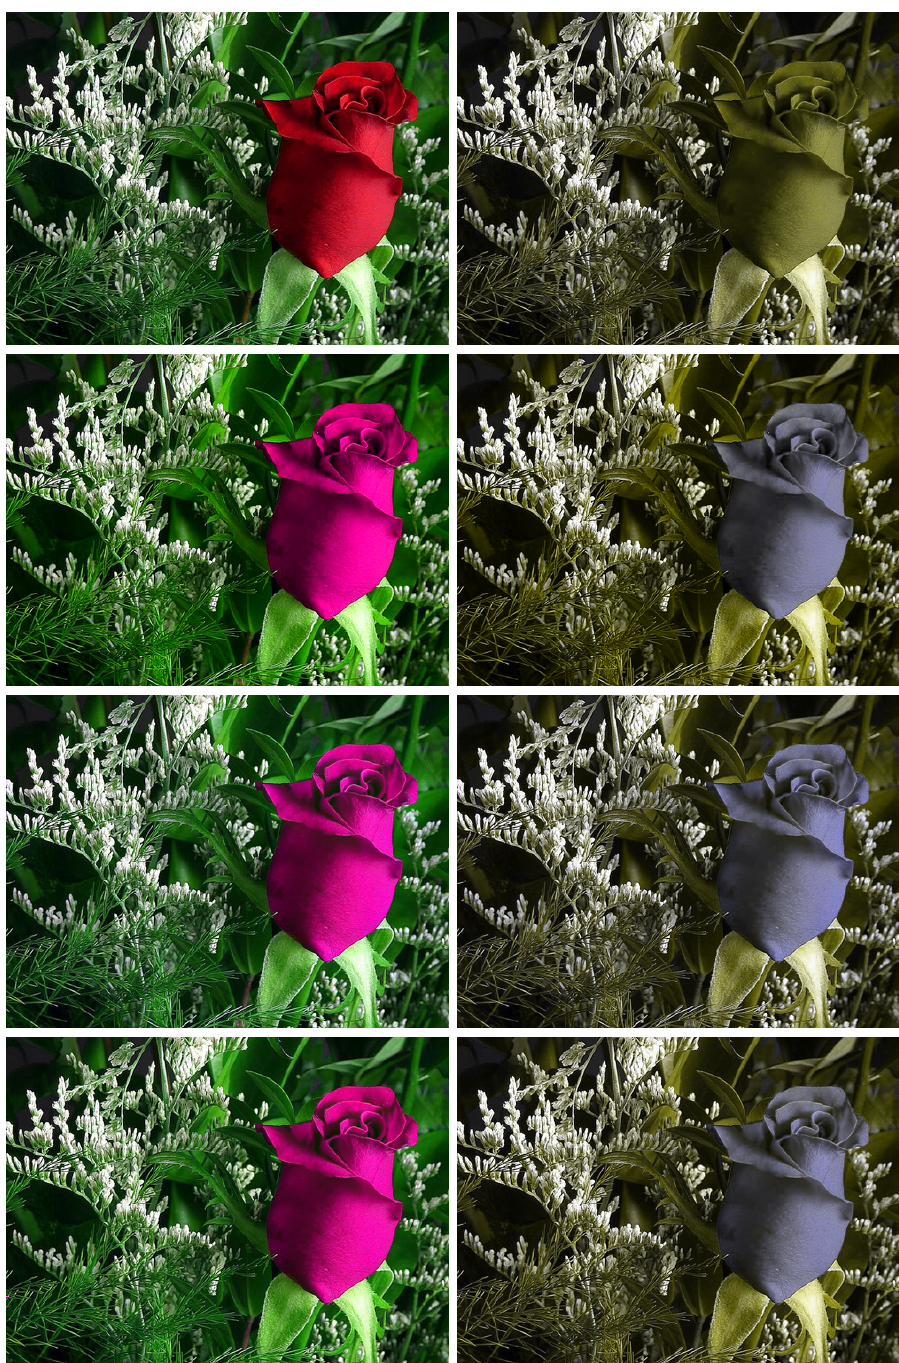
Figure 2. Sample image for an RG α = 1 dichromatic observer. ( Top to bottom , left hand column): original, simple daltonisation, isotropic daltonisation, and anisotropic daltonisation. Corresponding simulated images for a the RG α = 1 dichromatic observer in the right hand